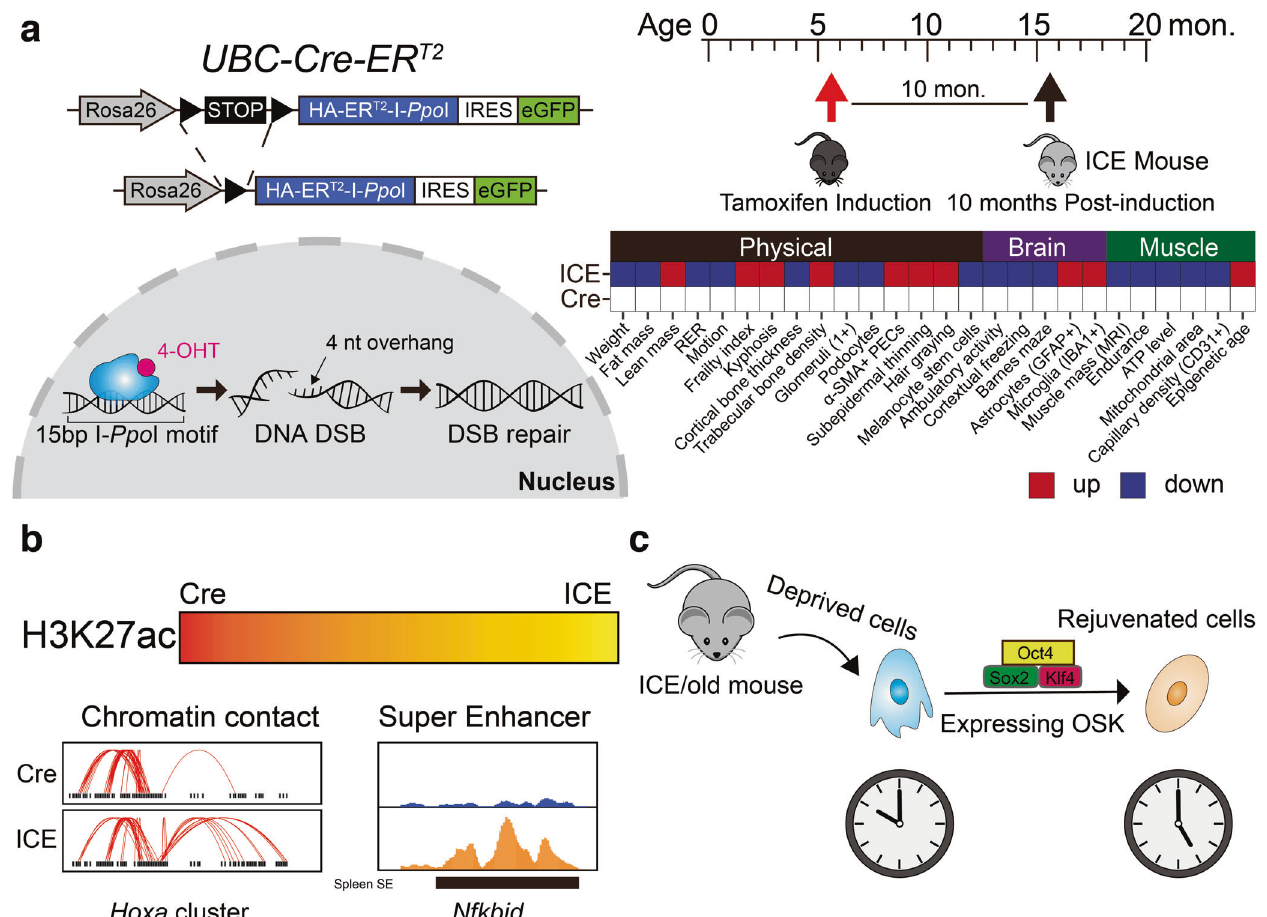
Fig. 1 Diagram and molecular mechanisms underlying the ICE mouse models. a left, the Inducible Change to the Epigenome (ICE) system. In this gene-engineering mouse model, recombined protein of endonuclease I- Ppo I and Cre-ER T2 is under control of tamoxifen. If tamoxifen is added, I- Ppo I will enter nucleus to create DNA double strand break which then will be repaired through faithful DNA repair pathway. right, aging phenotypes of ICE models. b Epigenetic landscapes changes in ICE model, including the erosion of H3K27ac, remodeling chromatin contact, and aberrant super enhancers. c The diagram of cell rejuvenation. Brie fl y, overexpression Oct4/Sox2/Klf4 in ICE/old mouse cells can recover youthful cell